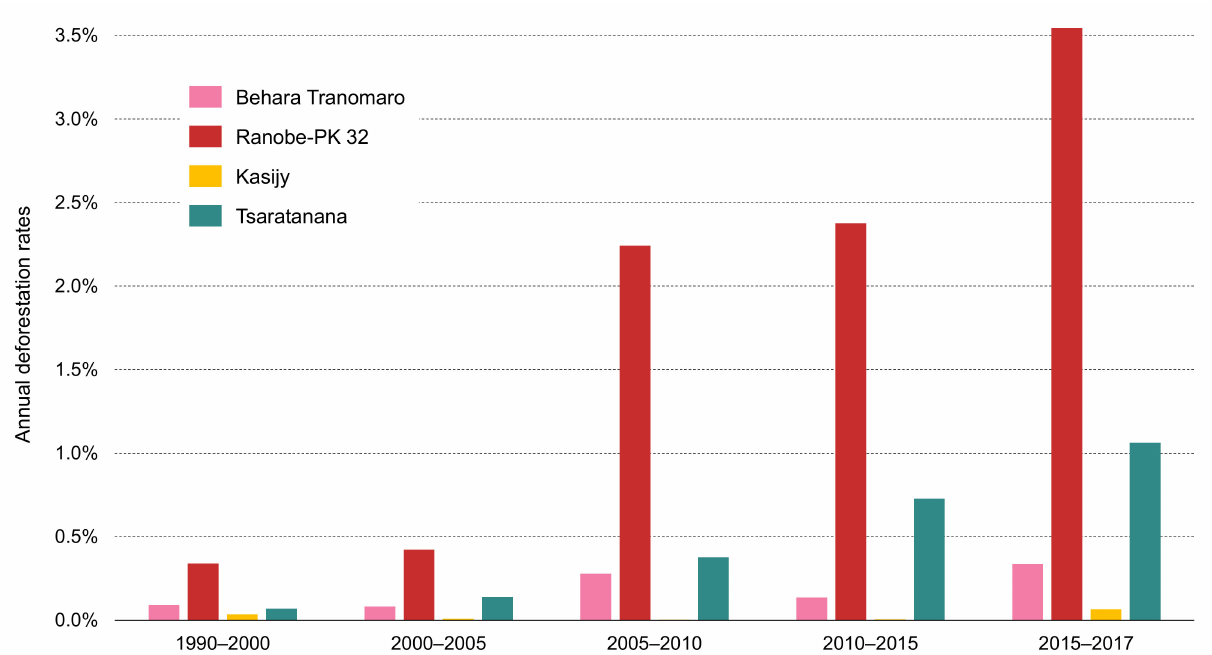
Figure 3. Annual deforestation rates in the four case study sites. (Behara Tranomaro and Ranobe-PK 32 had been gazetted in 2015; the deforestation rates have been calculated in previous years for the area gazetted in 2015; Tsaratanana total area under protection was doubled in 2015).